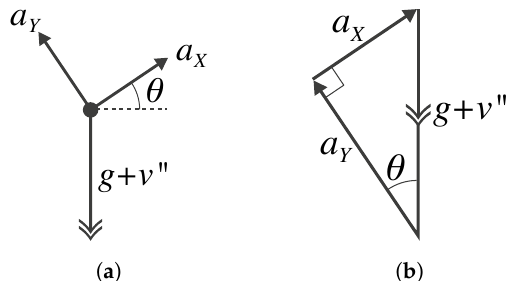
Figure 5. Sketches of ( a ) free-body diagram showing the apparent rotation of the Earth’s gravity ( g ) and vertical bridge acceleration ( v (cid:48)(cid:48) ) components; ( b ) equivalent vector diagram showing the x- and y-axis acceleration